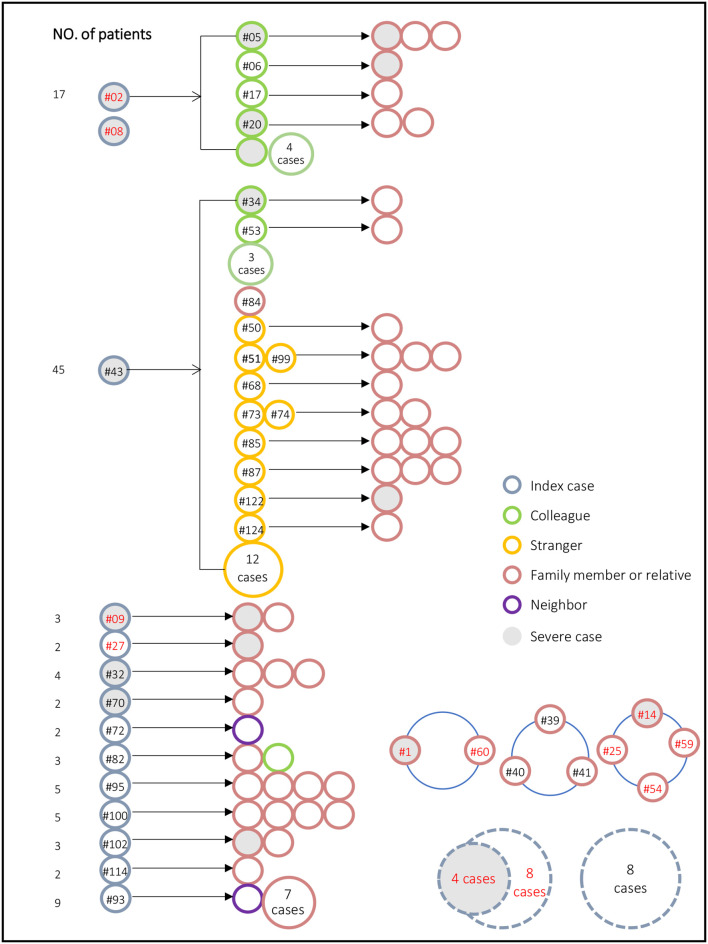
Transmission chain for the 131 confirmed COVID-19 cases in Tianjin. Red figures indicate a Wuhan-related exposure. Gray solid fill represents severe case. Numbers in dashed circle (lower right corner) represent the total number of unrelated independent events, and these patients did not transmit the virus to others. The blue hollow ring in the lower right corner indicates that these patients were infected at the same time or from the same source, for example, #14, #25, #54, and #59 traveled to Wuhan together.